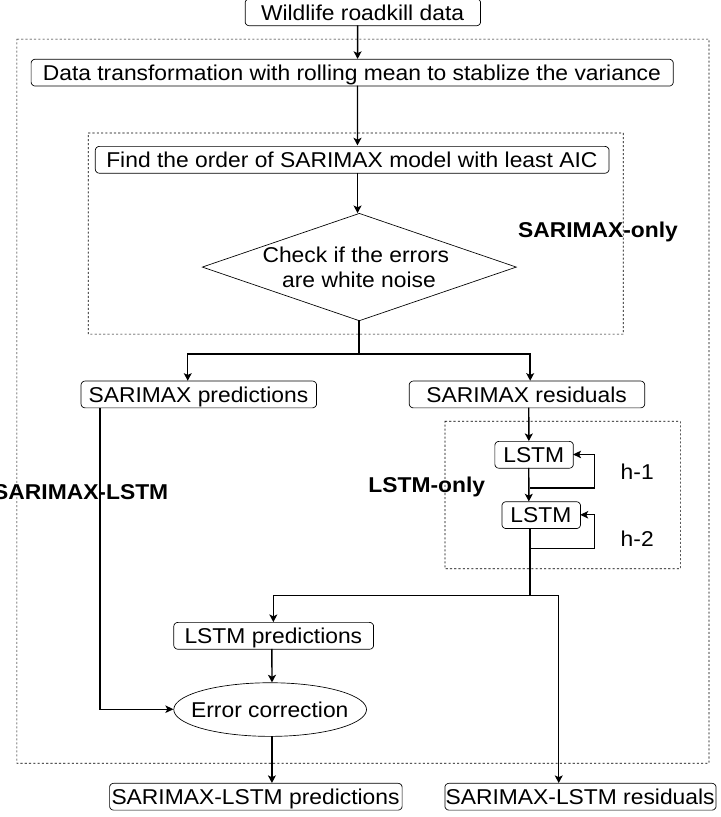
Figure 2. Flow chart showing the process for forecasting roadkill patterns using the SARIMAX- LSTM